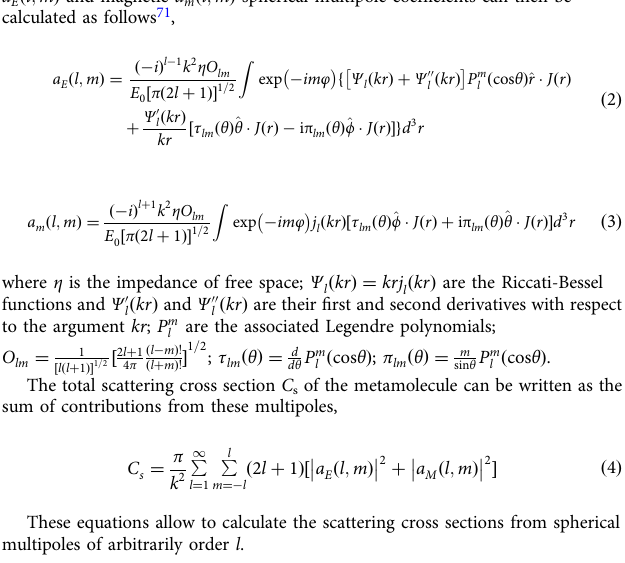
and, CD C , as EQ MQ and, CD C , as function of the EO MO S